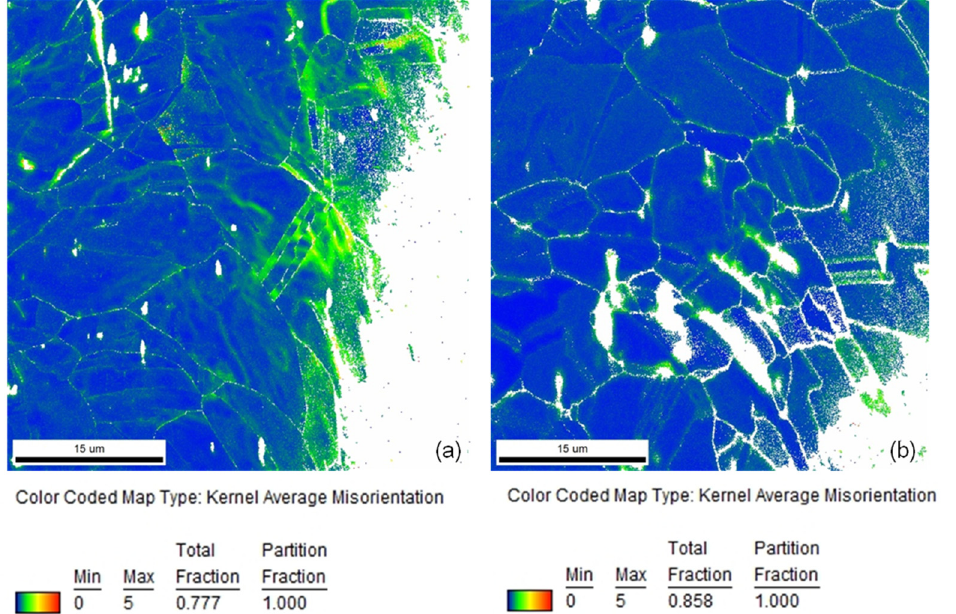
Figure 4. Comparison of local misorientation mappings of ( a ) a stent bow and ( b ) a stent strut of a Coroflex ® Blue Stent (coloring according to the